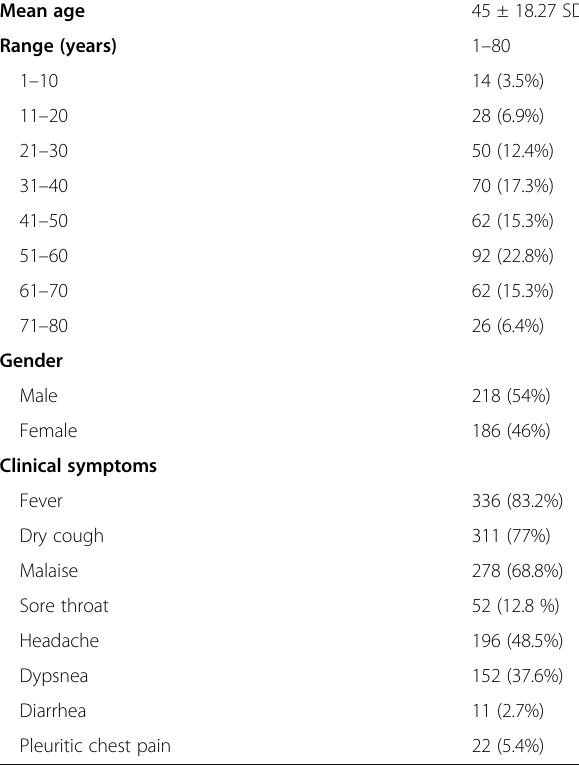
Table 1 Demography and clinical characteristics of the studied population